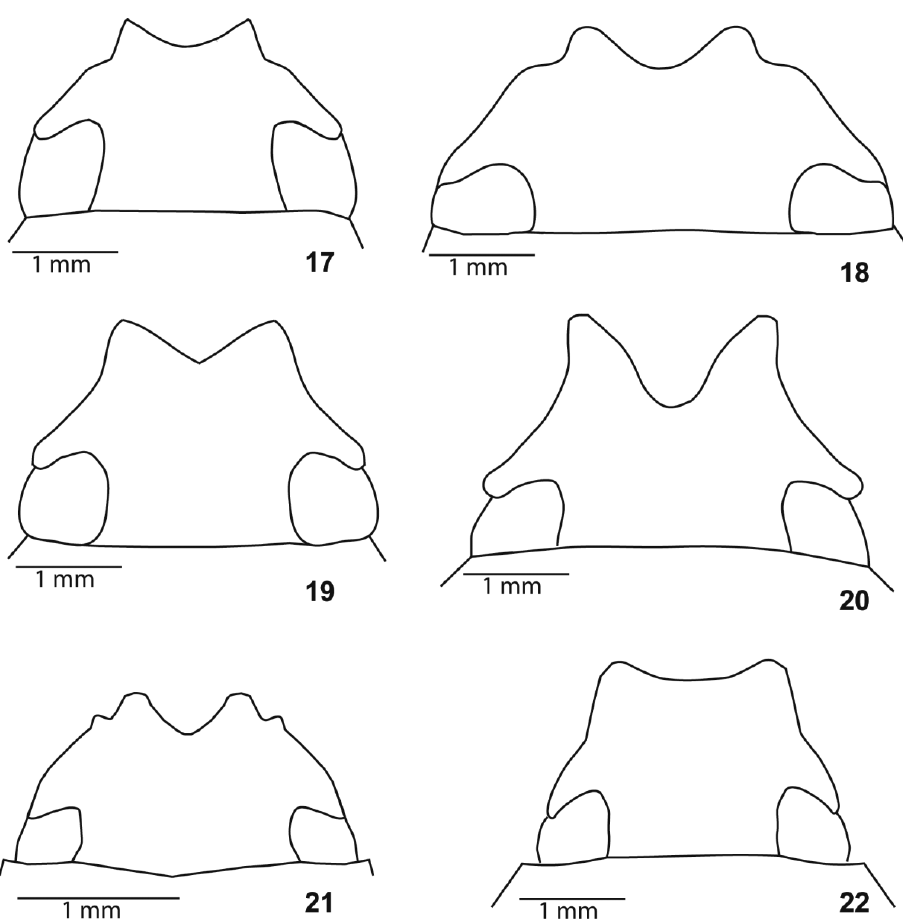
Figures 17–22. Clypeus. 17 Liogenys acutidens Moser 18 L. fusca Blanchard 19 L. santaecrucis Blan- chard 20 L. bilobata Frey 21 L. corumbana Moser 22 L. rectangula Frey. metatibiae wider, mainly on the apex; not carinated on inner margin; tarsi cylindrical and equally wide in all legs. Abdomen : the pygidium may differ from the male in the shape and roundness, and this difference varies among the species. Male . Length: 6.5– 14.7 mm; width: 3.5–7.2 mm. Head : Lamellae generally longer or equal to flagellum, in a few cases shorter; clypeal lateral projection, when present, may be more pronounced than in the female of certain species. Legs : protibiae with two or three teeth; posterior margin of metafemur generally straight but may be produced medially in some species (Fig. 10), metatibiae widened towards apex; carinated along the inner margin entirely or excepting the apex; the inner margin commonly straight towards apex, in some cases is produced abruptly from the sub-basal or medial portion (Fig. 10); metatibial inner margin not carinated in a few cases; apex setose throughout the inner surface but in a few cases glabrous; on posterior surface, one or two transverse carinae and